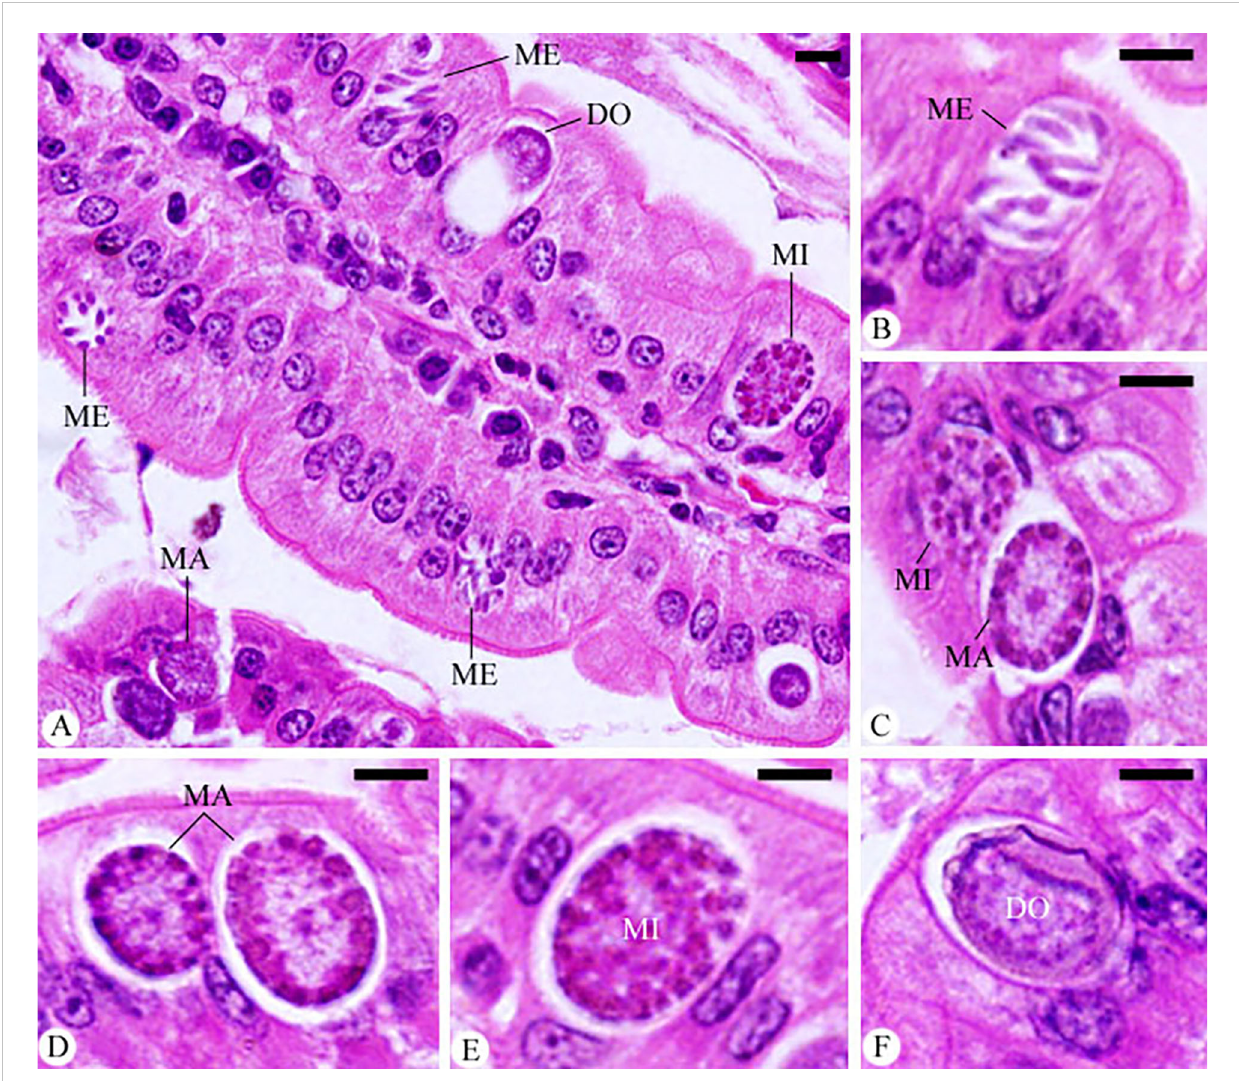
FIGURE 4 Infected jejunum with Eimeria papillata on day 5 p.i. (A) different developmental stages. (B) meronts (ME). (C) macrogamont (MA) and microgamont (MI). (D) macrogamont (MA). (E) microgamont (MI). (F) developing oocyst (DO). Sections were stained with hematoxylin and eosin (H&E). Scale bar=